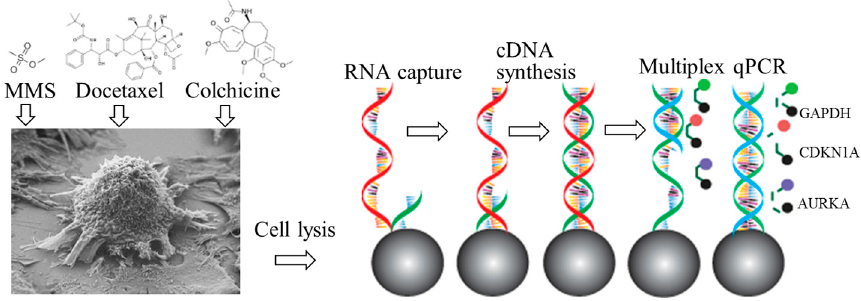
Figure 1. Principle of microfluidic integrated single-cell gene expression profiling. The human cancer cells were isolated and immobilized in the microchip. Then, the cells were chemically lysed and the released mRNA templates were captured and purified by magnetic microbeads followed by RT and multiplex qPCR. The amplification of three targets ( GAPDH, CDKN1A, AURKA ) were detected in real-time using sequence-specific probe/primer sets.